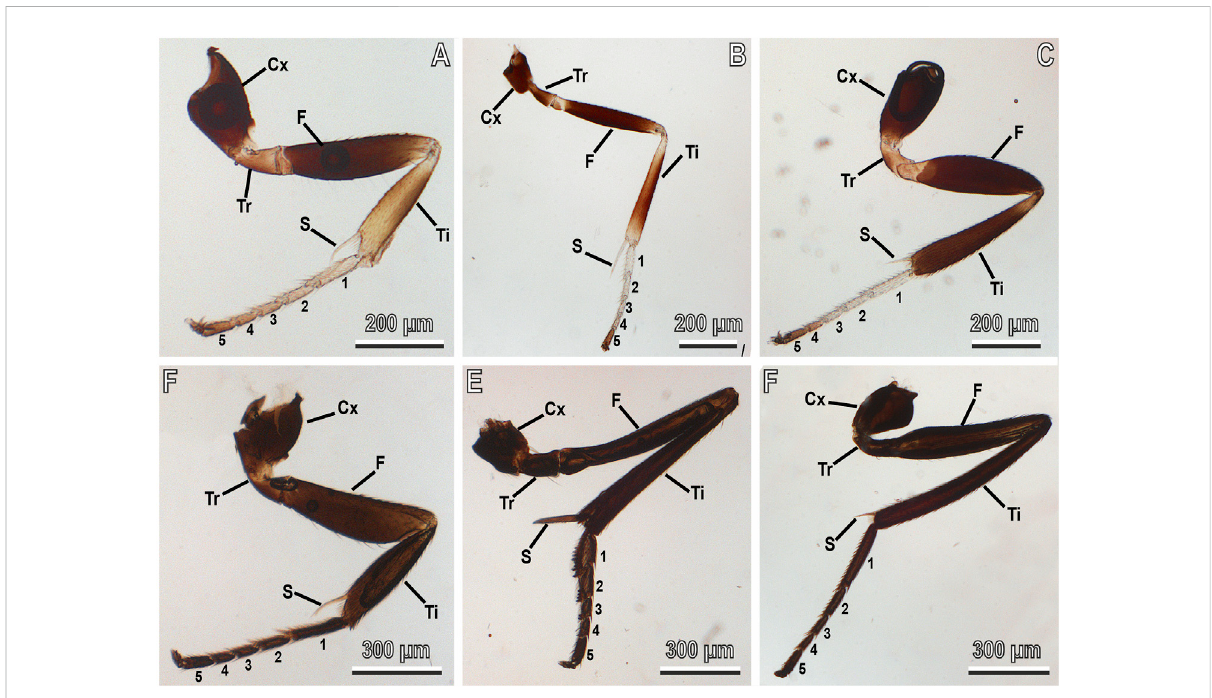
FIGURE 1 Legs of A. bifasciatus , light microscopy. Male foreleg (A) , midleg (B) and hindleg (C) ; Female foreleg (D) , midleg (E) and hindleg (F) . Tarsi of both sexesarecomposedof fi vetarsomeres(1 – 5).Note (E) thatinthefemale,thetarsiofthemediumlegshaveacurvedshapeandthe fi rsttarsomere(1)is wider than the others. Cx, coxa; F, femur; Ti, tibia; Tr, trochanter; S, tibial